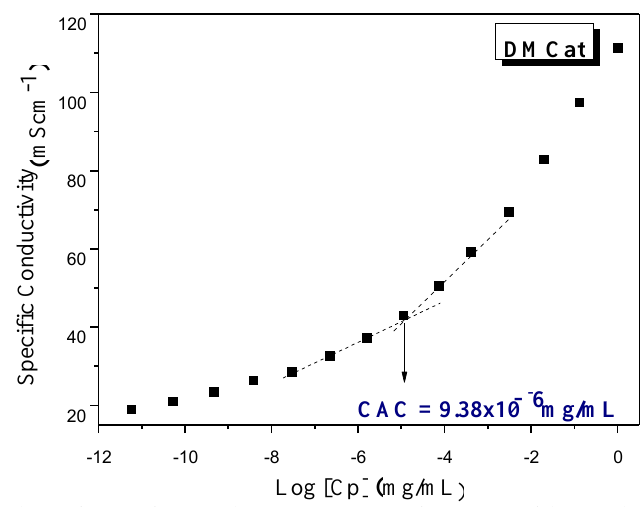
Figure 3. Graphic of specific conductivity versus function of logarithm concentration of DMCat of 1 mg/mL to 1 × 10 −6 mg/mL. DMCat sample solubilized in water.